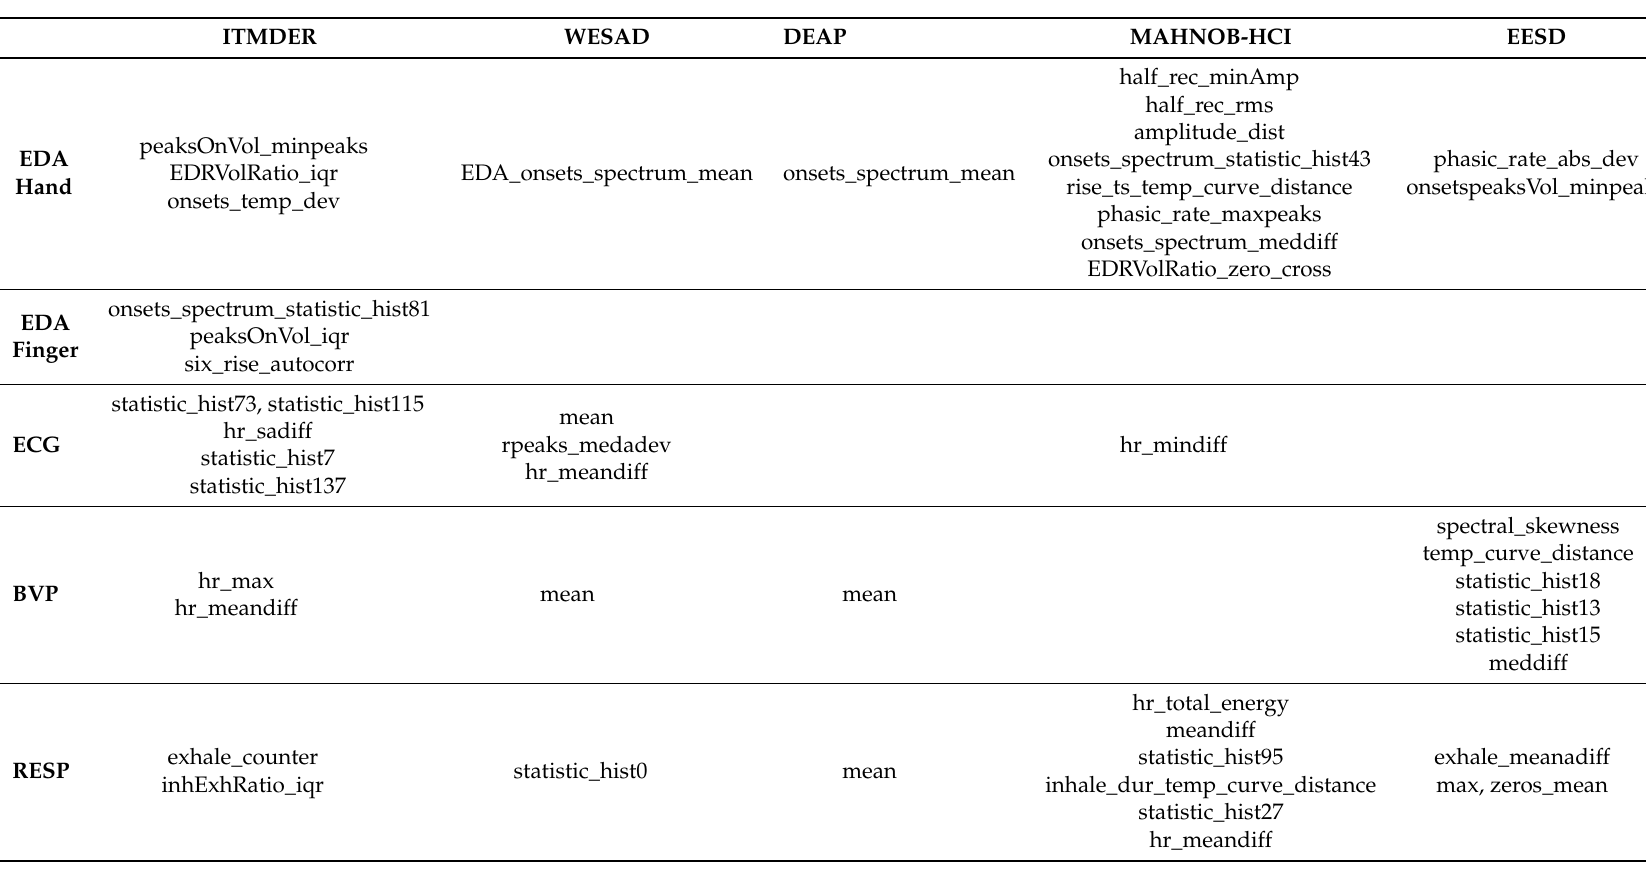
Table 4. Features used per dataset and sensor modality for the Arousal dimension in the SL and DF methodologies, obtained using 4-fold